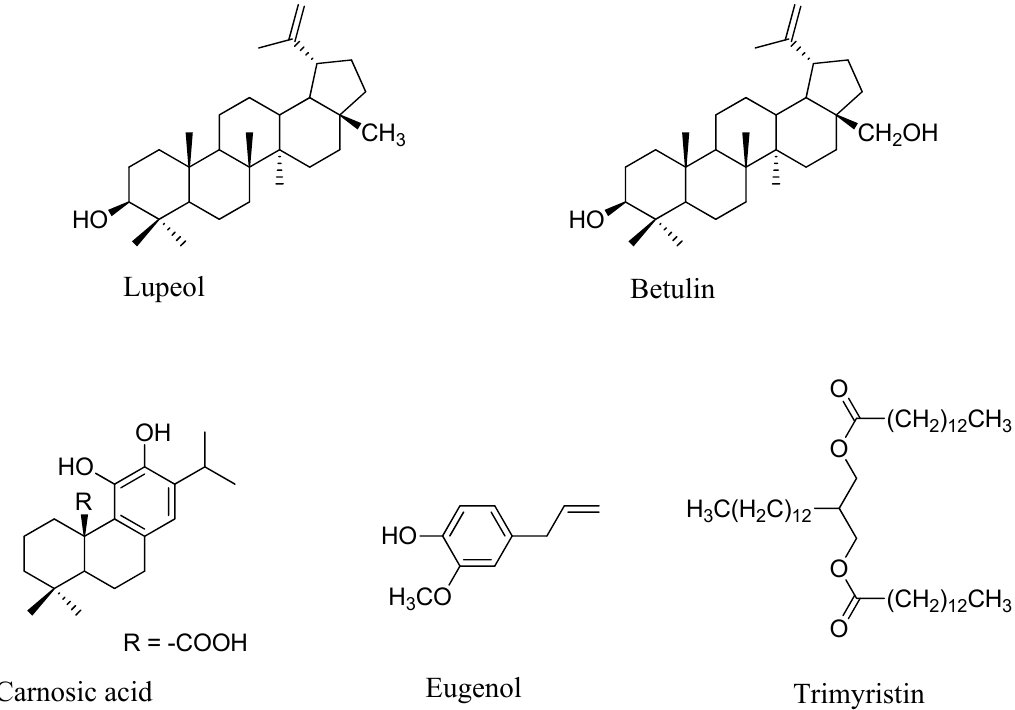
Figure 1. Compounds extracted using a mixture of water, ethyl acetate end ethyl alcohol.